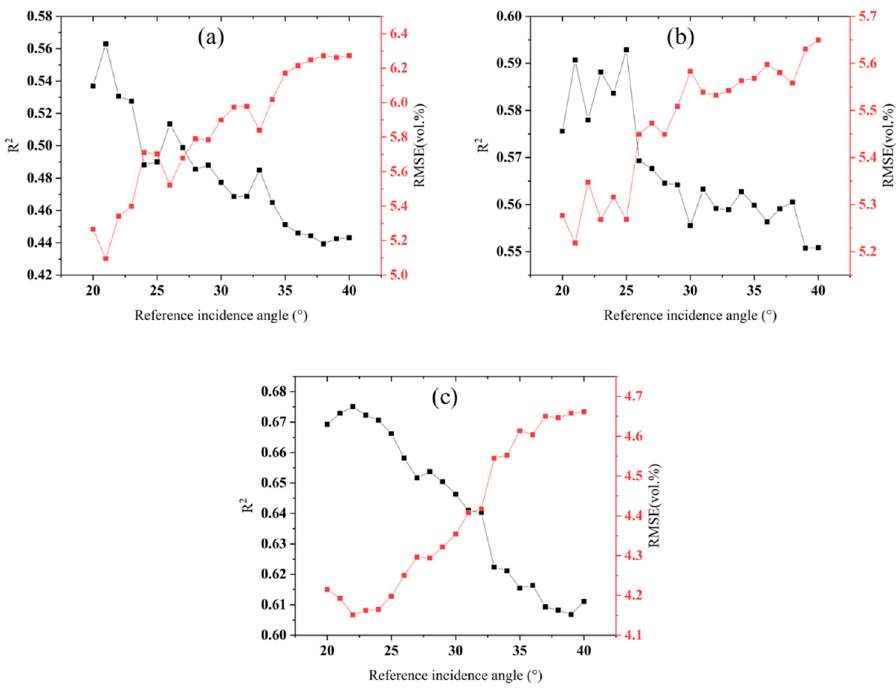
Figure 12. SMC estimation accuracy based on ratio method with different reference incidence angels. ( a ) RVI; ( b ) LAI; ( c ) NDVI.